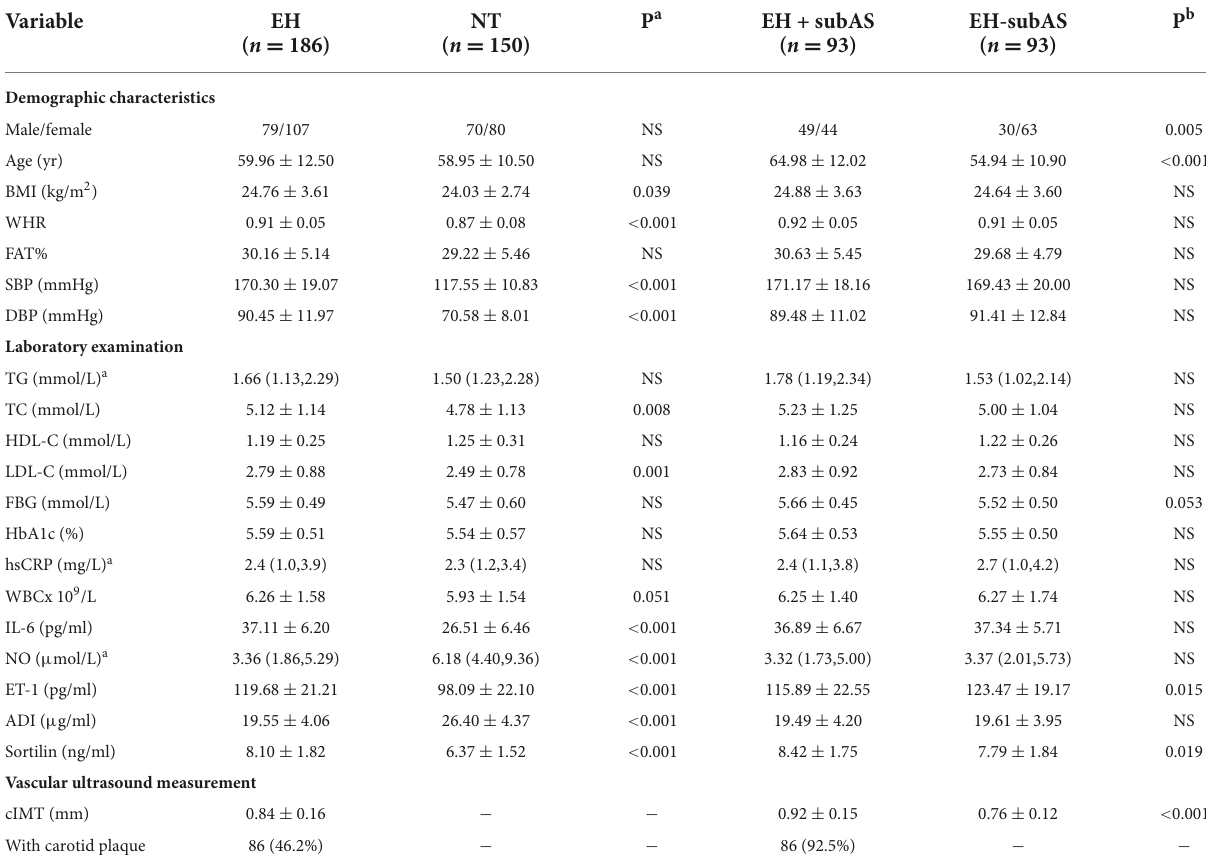
TABLE 1 Clinical characteristics of study subjects.